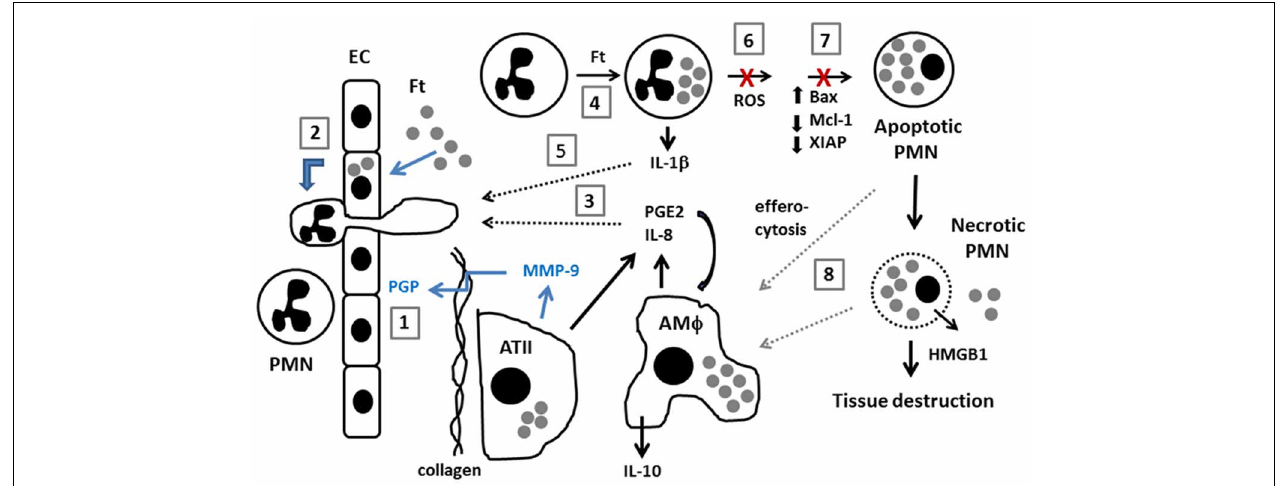
FIGURE 1 | Model of neutrophil dynamics in the F. tularensis -infected lung. Inhaled F . tularensis rapidly infects alveolar type II (ATII) cells and macrophages (AM (cid:2) ) (Gentry et al., 2007). (1) MMP-9, likely secreted by ATII cells, cleaves collagen, generating PGP which directly stimulates PMN recruitment from the bloodstream (Malik et al., 2007). (2) PMN migration is also stimulated by direct infection of pulmonary endothelial cells (EC) by an IL-8 and MCP-1-independent mechanism (Moreland et al., 2009). (3) F. tularensis stimulates release of PGE2 and IL-8 from AM (cid:2) and ATII cells (Gentry et al., 2007; Woolard et al., 2007). PGE2 stimulates macrophage production of IL-10 (Hunt et al., 2012). (4,5) F. tularensis infects PMNs and upregulates IL-1 β (Schwartz et al., 2013). The extent to which PGE2, IL-8 and